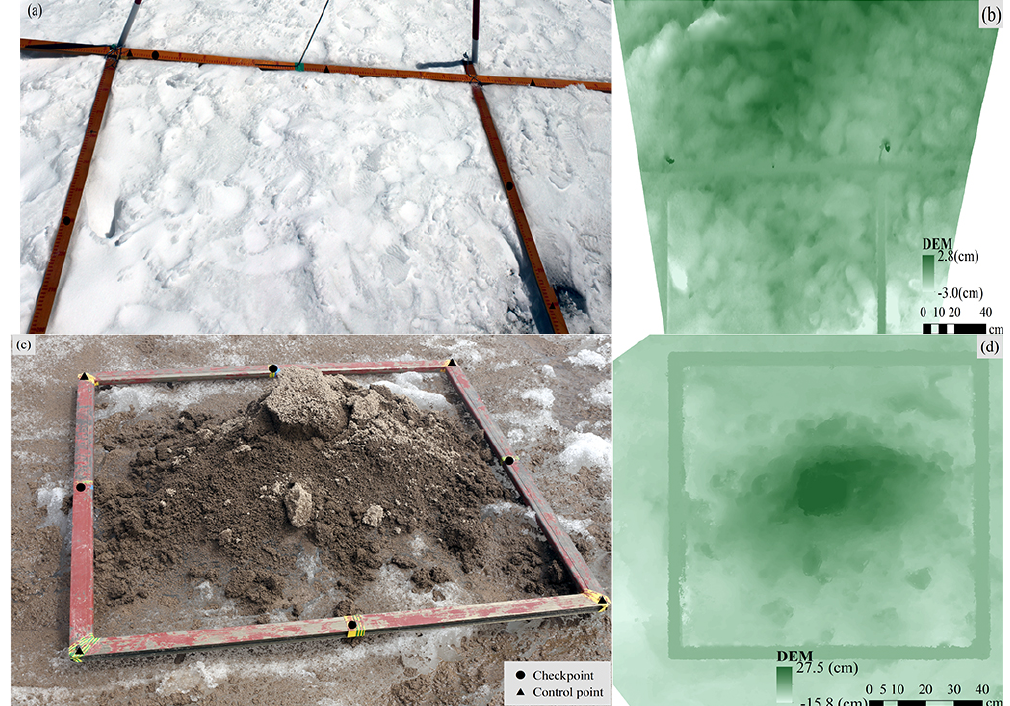
Figure 3. Frames used for automatic and manual photogrammetry. (a) Wooden frame in situ set up for automatic photogrammetry; four control points and three checkpoints are shown on the frame. (b) Detrended DEM for the corresponding snow surface of (a) . (c) Manual observation plot, with the four control points and four checkpoints shown on the aluminum frame. Ice surface hummock was covered with cryoconites. (d) Detrended DEM for the corresponding cryoconite surface of (c)